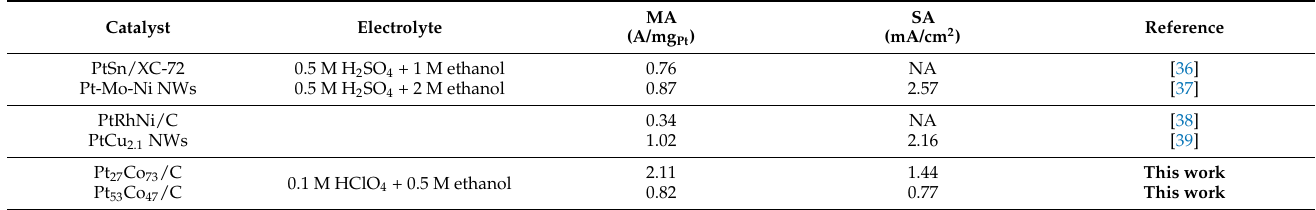
Table 2. Comparison of EOR activities of various catalysts.